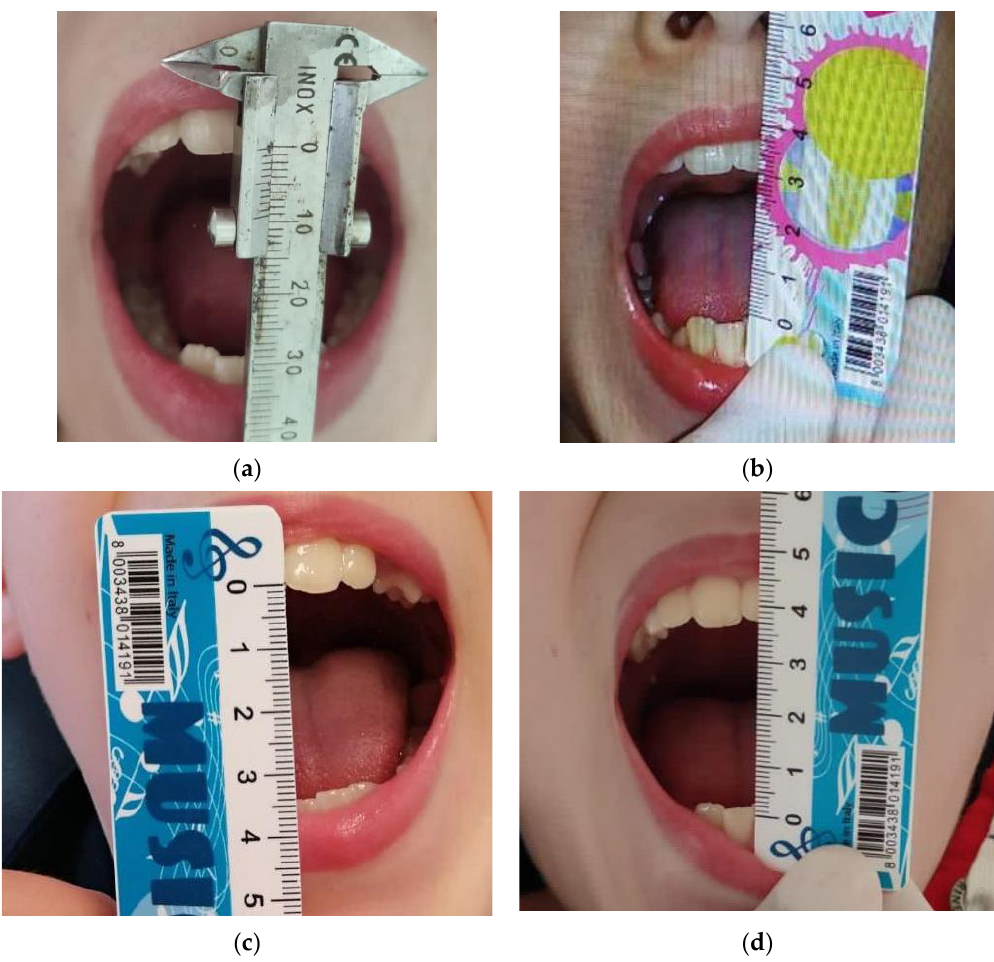
Figure 3. ( a ) Clinical evaluation after the third appointment. ( b ) Clinical evaluation after the fourth session (30 mm of maximum opening). ( c ) Clinical evaluation after fifth appointment (35 mm of maximum opening). ( d ) Clinical evaluation after last session, with a maximum opening of 38 mm.